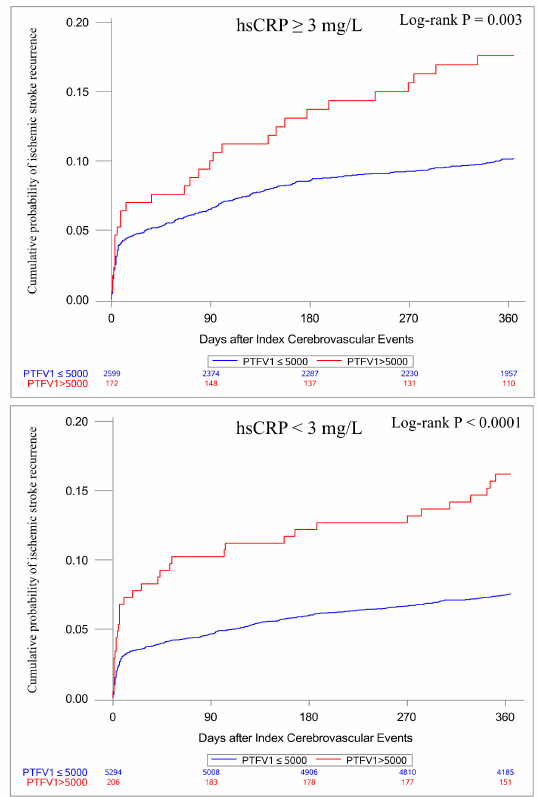
Figure 2. Kaplan–Meier curves for probability of ischemic stroke recurrence classified by hsCRP. hsCRP, high-sensitivity C-reactive protein; PTFV1, P-wave terminal force in lead